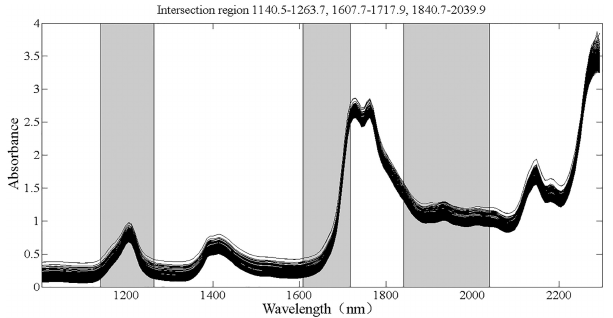
Fig. 3. The position of the public regions on the original spectra.